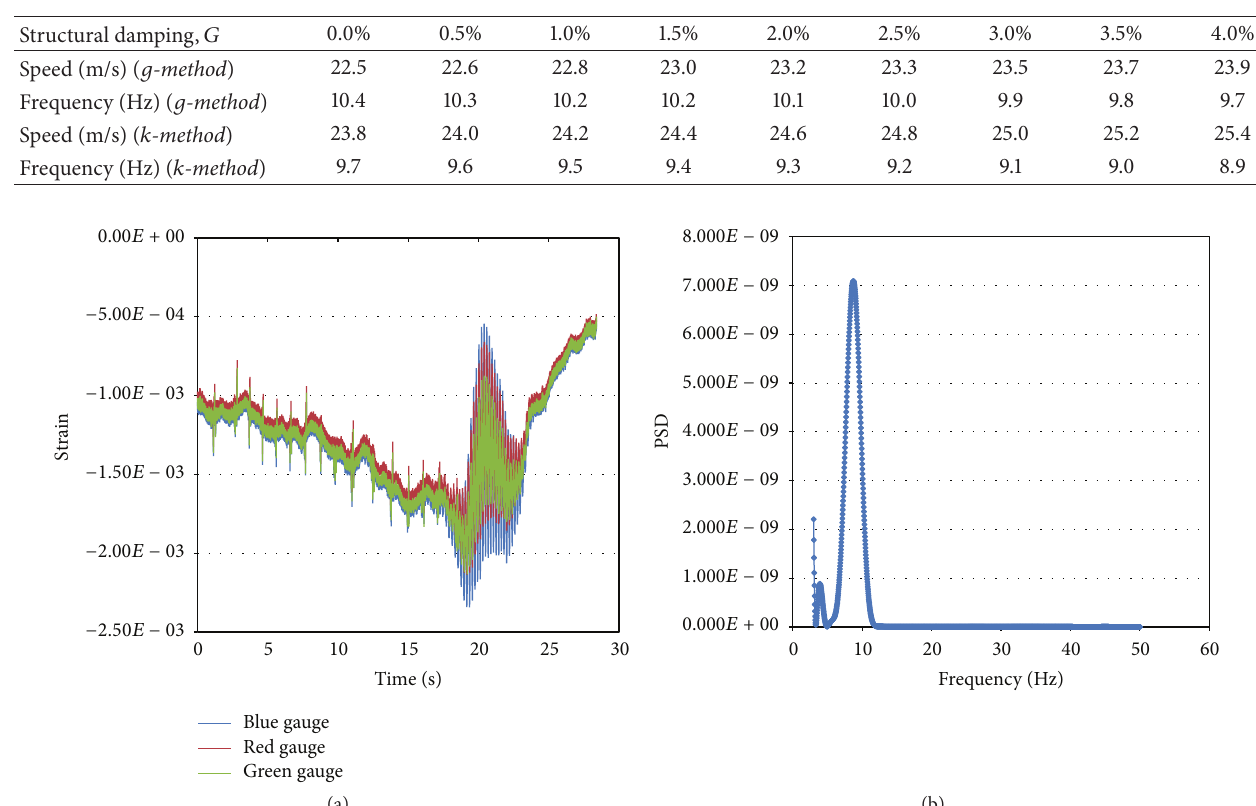
Table 4: Flutter speed analysis results of the rectangular plate.